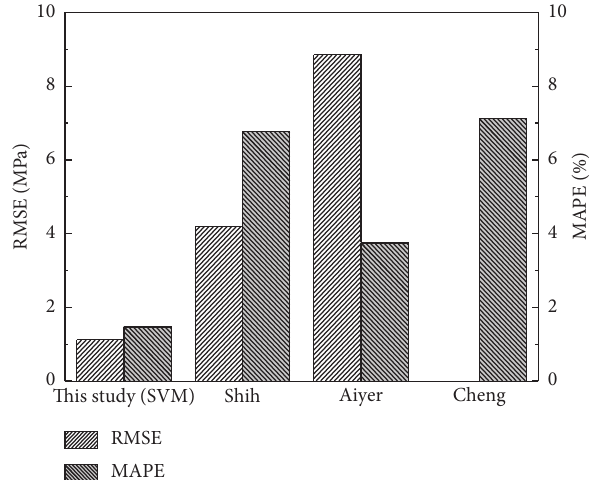
Figure 12: Comparison between AE parameters and other pa- rameters in terms of RMSE and